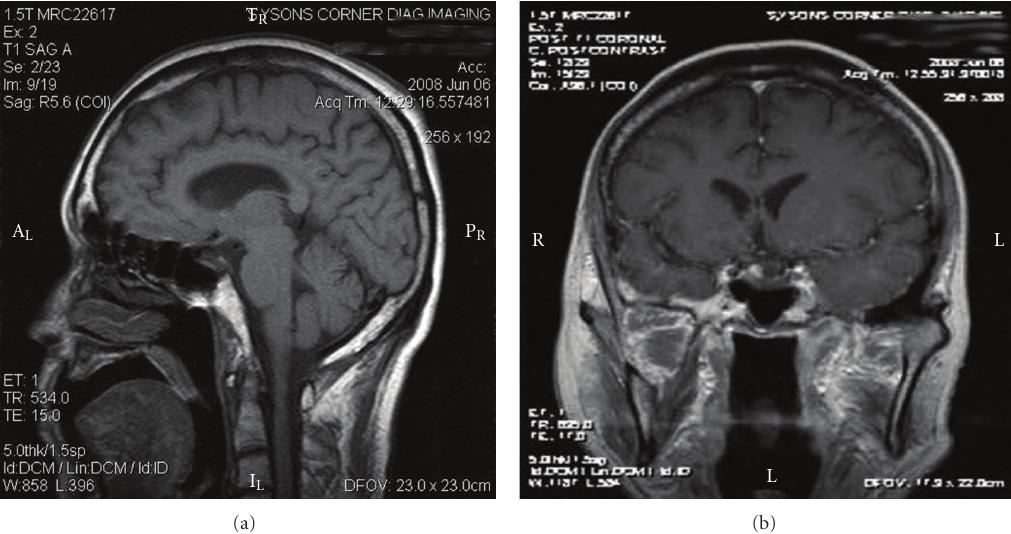
Figure 2: Sagittal and coronal postcontract MRI in early June revealing an empty sella without evidence of pituitary mass or cystic